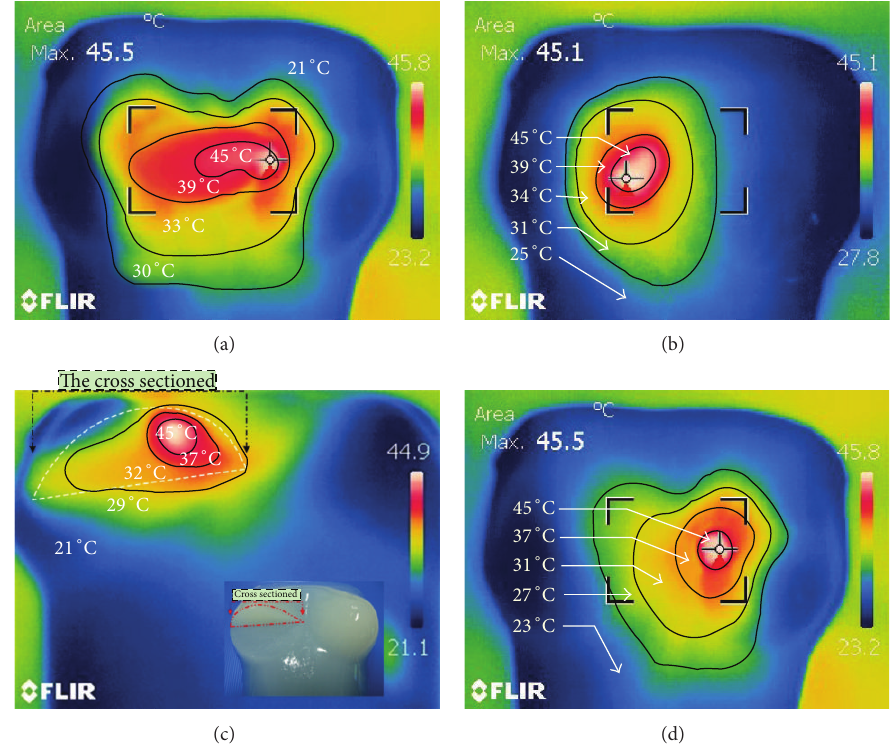
Figure 11: The temperature of the agar phantom: (a) the temperature distributions for the ferrite cores applicator without shielding plates, (b) the temperature distributions with shielding plates at the original position, (c) the temperature distributions in the cross-section, and (d) the temperature when the ferrite cores applicator offsets from original position in the 𝑥 -direction by a value equal to